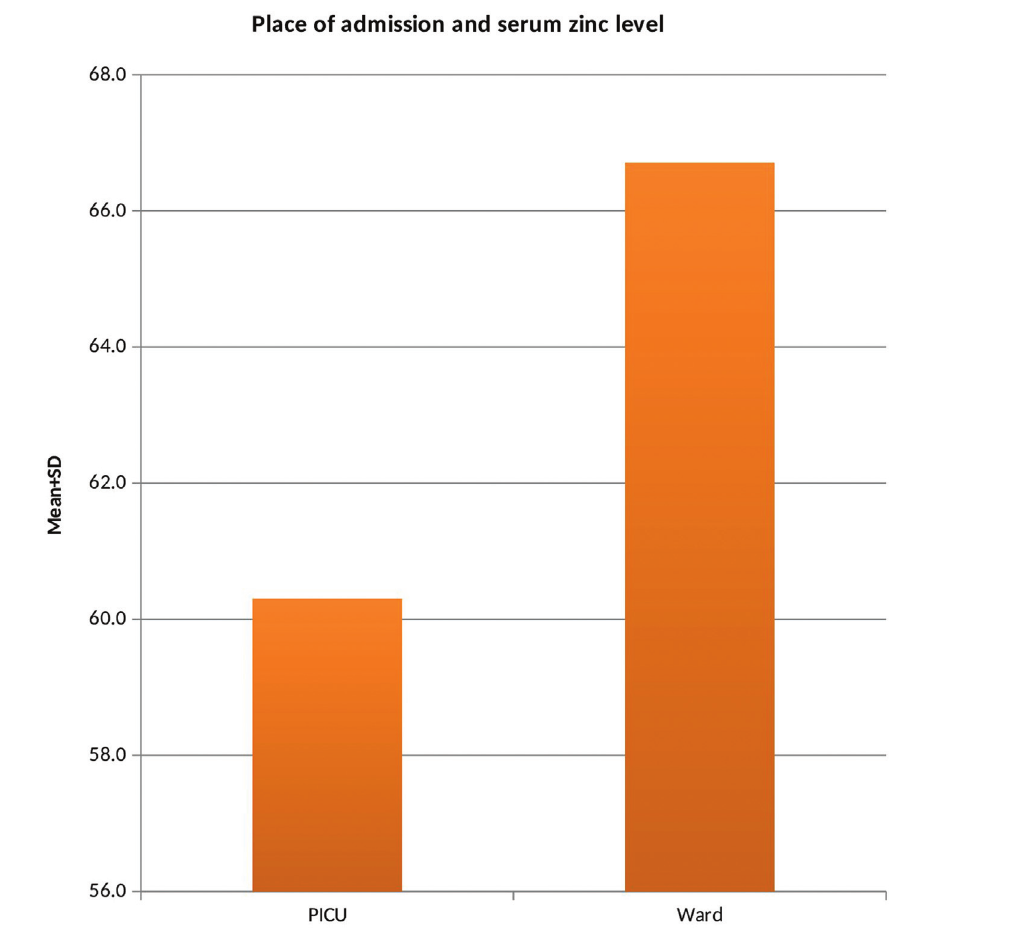
Comparison of serum zinc level according to the place of admission, among patients ( N